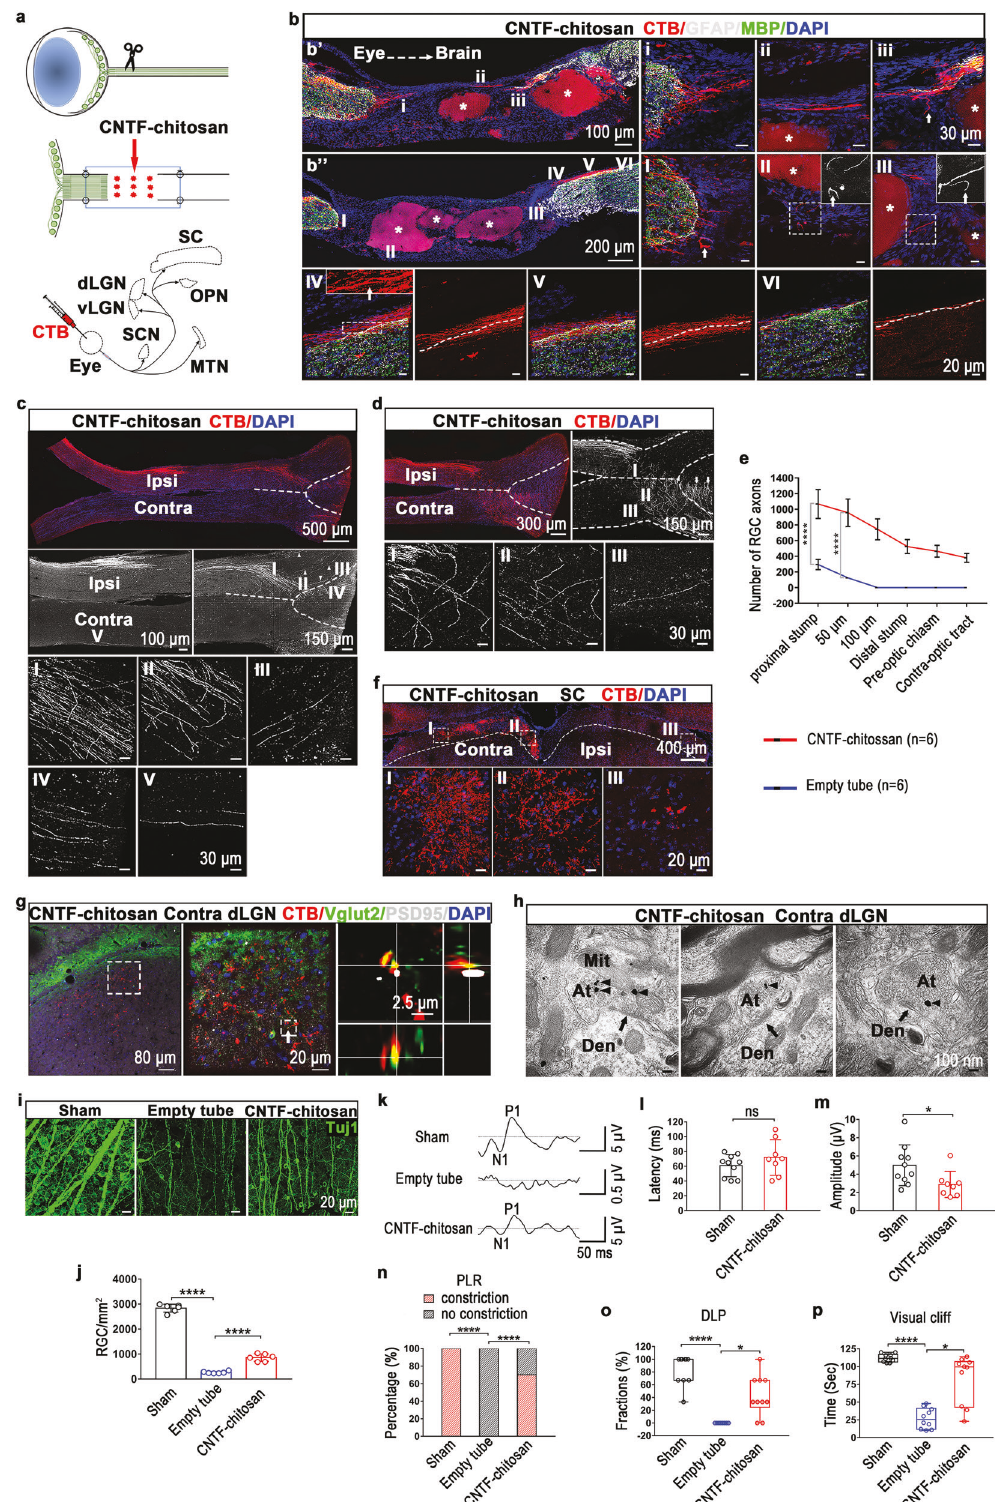
(PLR), dark-light preference (DLP), and visual cliff test to evaluate the recovery of visual functions in rats. First, we measured the F-VEP. 80% of the rats in the CNTF-chitosan group could evoke VEP (Fig. 1k). Compared with the sham control group, the latency of the P1 wave slightly prolonged (71.83 ± 24.05 ms vs.